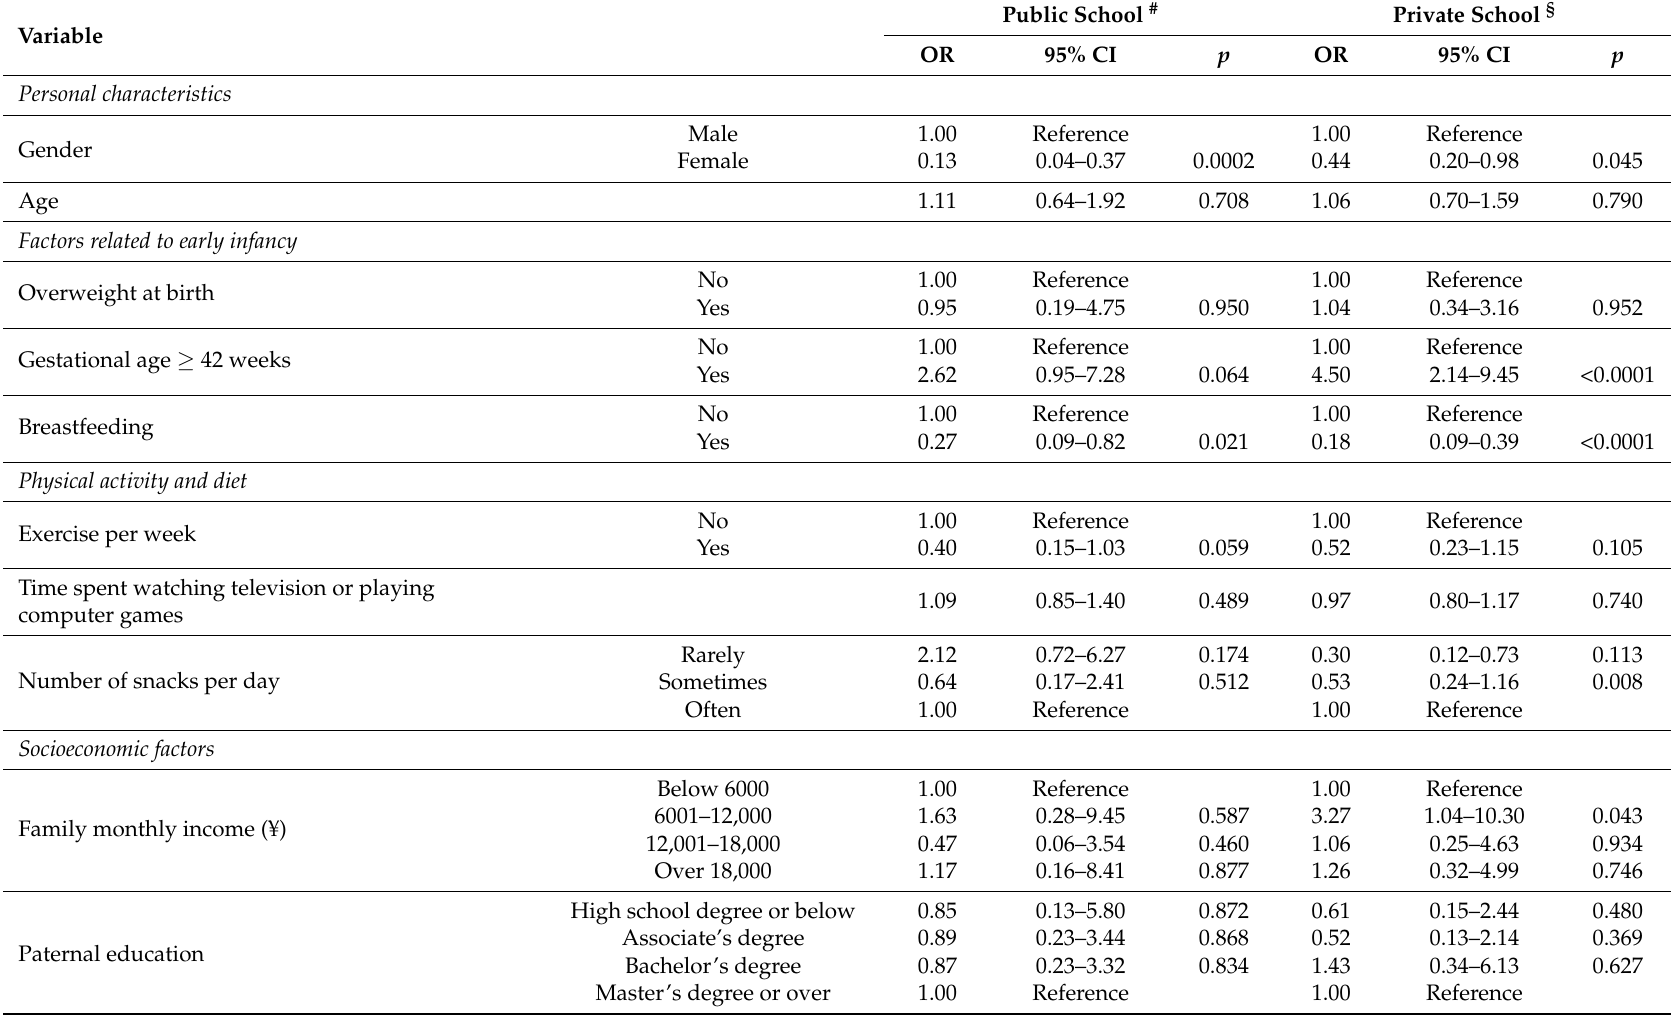
Table 3. Logistic regression analysis of the differences among overweight adolescents in the two types of